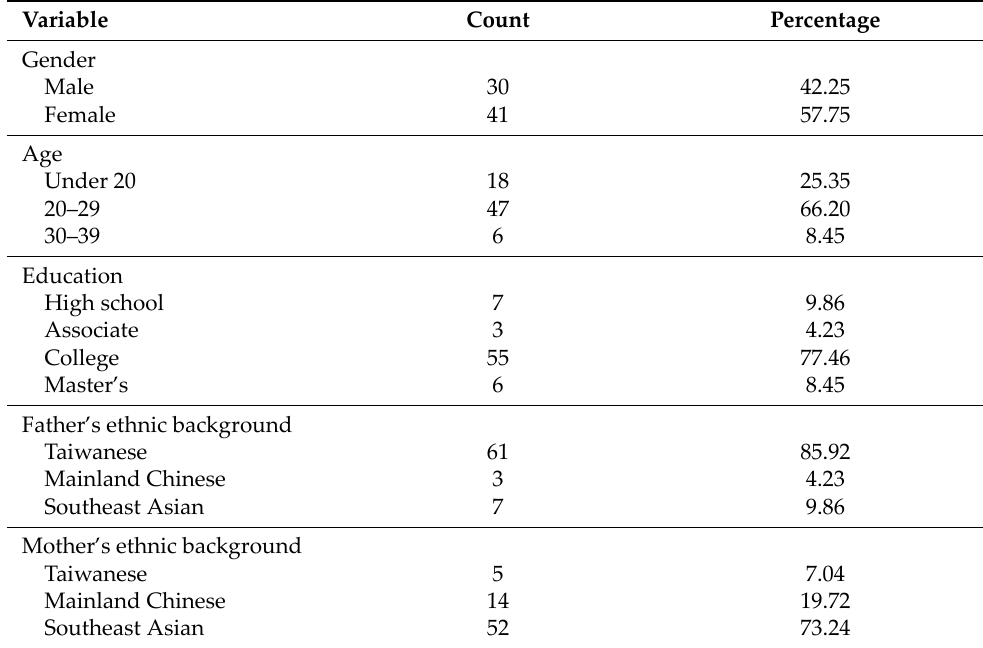
Table 1. Descriptive statistics for survey background